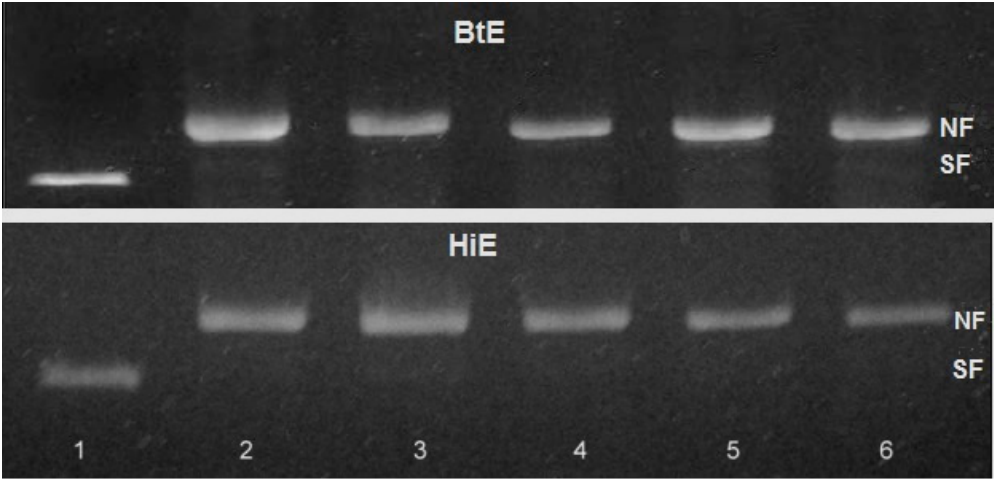
Figure 5. Photoprotection of B. triquetrum and H. incrassata extracts on plasmid DNA-UVC-irradiated (200 J/m 2 ), and then digested with T4-endo V enzyme: (1) Negative control; (2) Positive control; (3–6) DNA exposed to 0.01, 0.1, 0.5 and 1.0 mg/mL of extracts. SF: supercoiled form. NF: open nicked form.